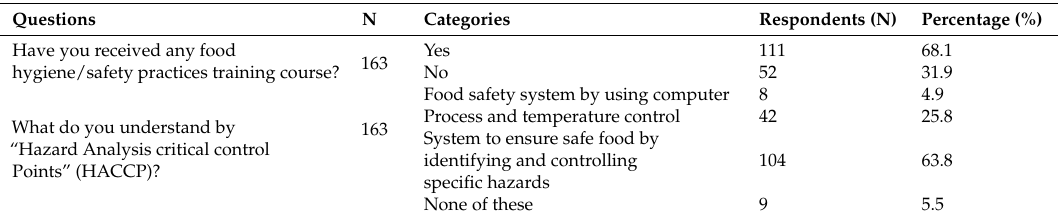
Table 2. Food handlers’ replies on food safety training questions.